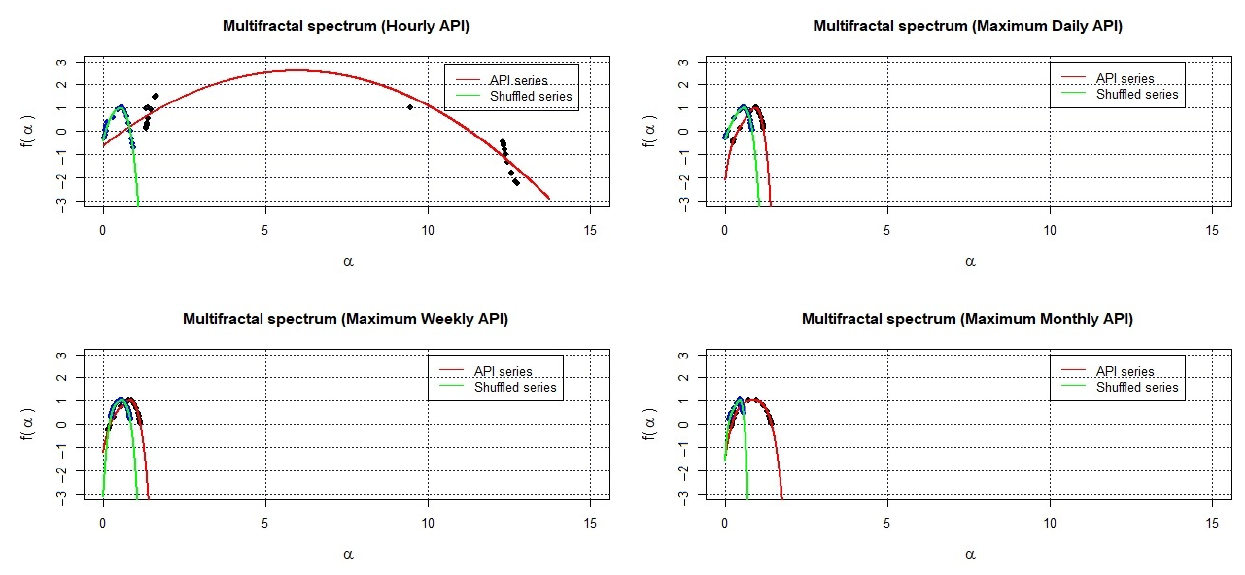
Figure 8. Multifractal spectrum plots. Table 2. Multifractal parameters air pollution series in Klang.